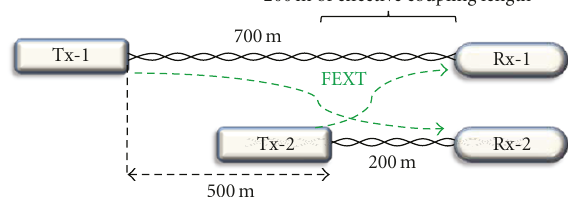
Figure 9: Access network scenario III with two FEXT channels of unequal